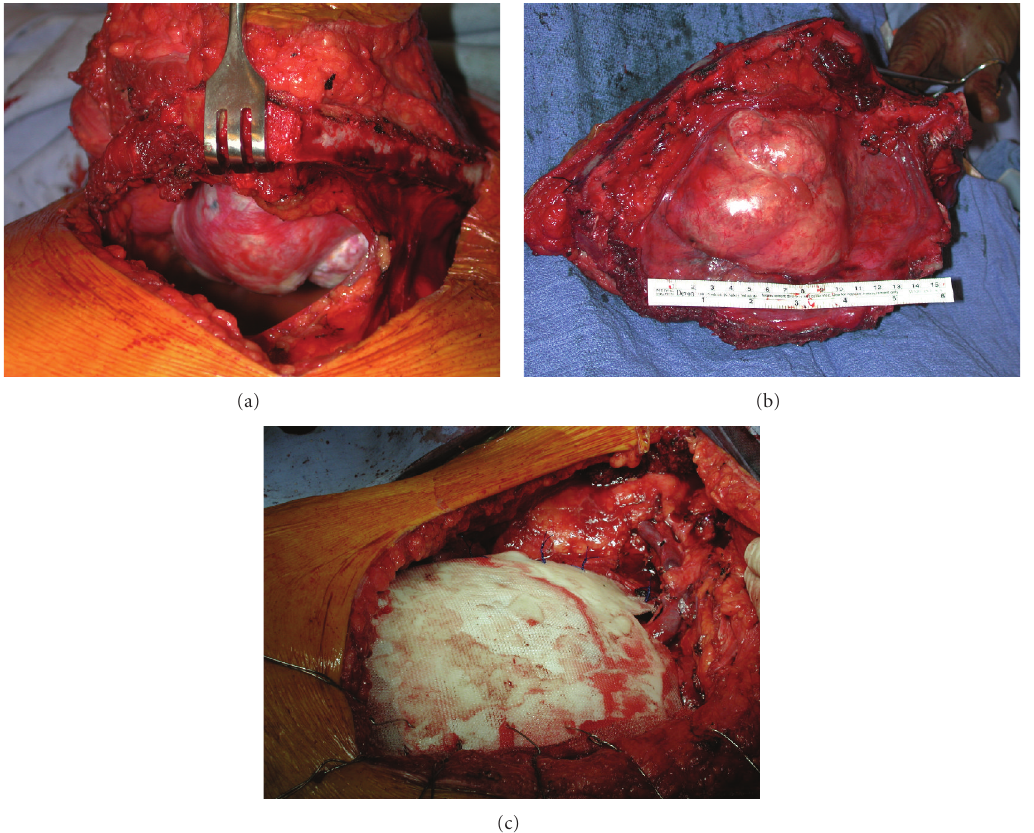
Figure 3: Intraoperative photographs taken during resection of an anterior thoracic chondrosarcoma and subsequent reconstruction using polypropylene mesh and methyl methacrylate. The initial thoracotomy is created at least one rib below the level of palpable tumor (a). Surgical specimen following radical excision with adequate wide margins (b). Following reconstruction of the right anterior chest wall using polypropylene mesh and methyl methacrylate